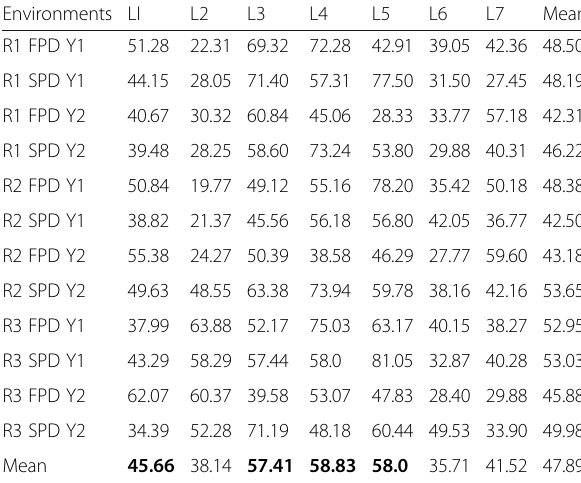
Table 10 The mean values for the seven rice entries under the 12 environments for flag leaf area Environments LI